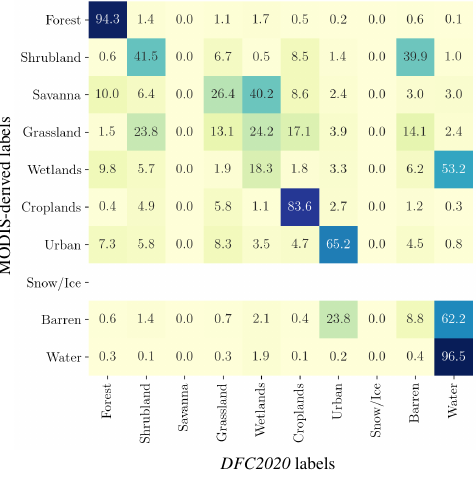
Figure 3. Class transition matrix from low-resolution, MODIS-derived labels to high-resolution DFC2020 labels. mentation network (i.e. the Unet relying on only Sentinel-2) is shown in Fig.